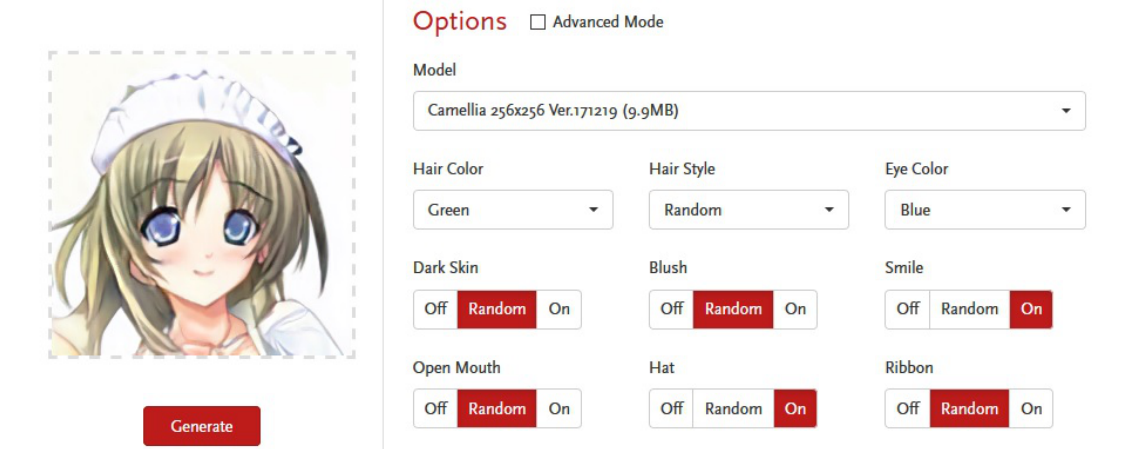
Figure 8. Example of a random character generation based on Jin and coworkers’ method [56]. In this example, we set some attributes such as green hair color, blue eyes, smile and hat. Image captured from the online demo [57].